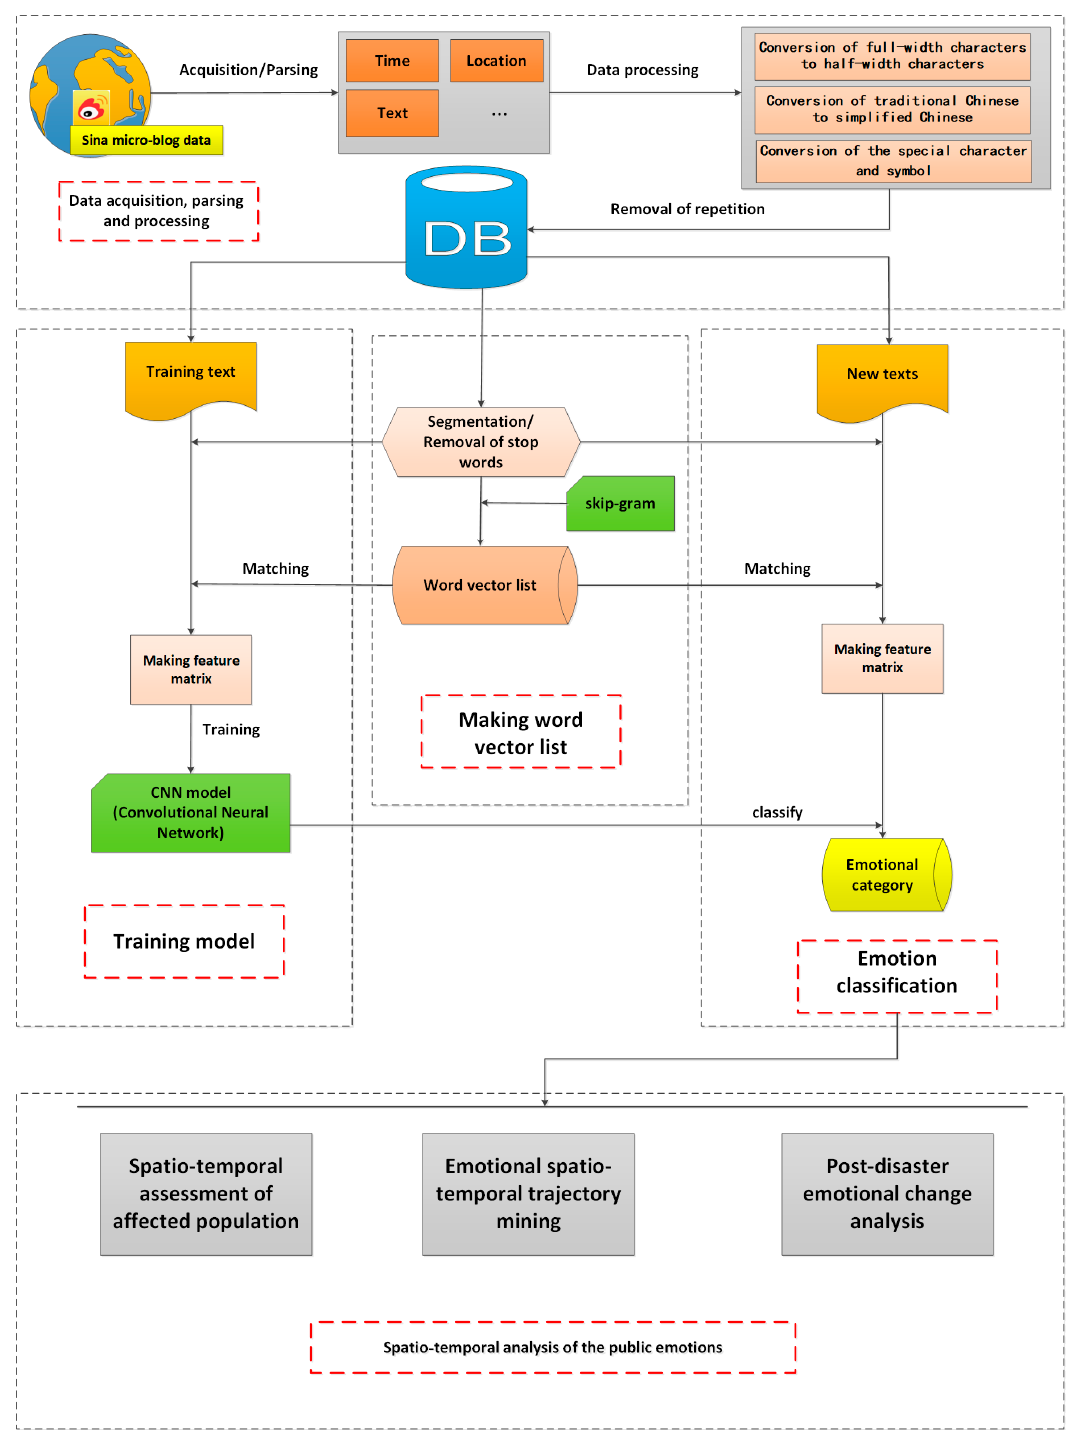
Figure 1. Framework of the automatic emotion classification and disaster analysis.